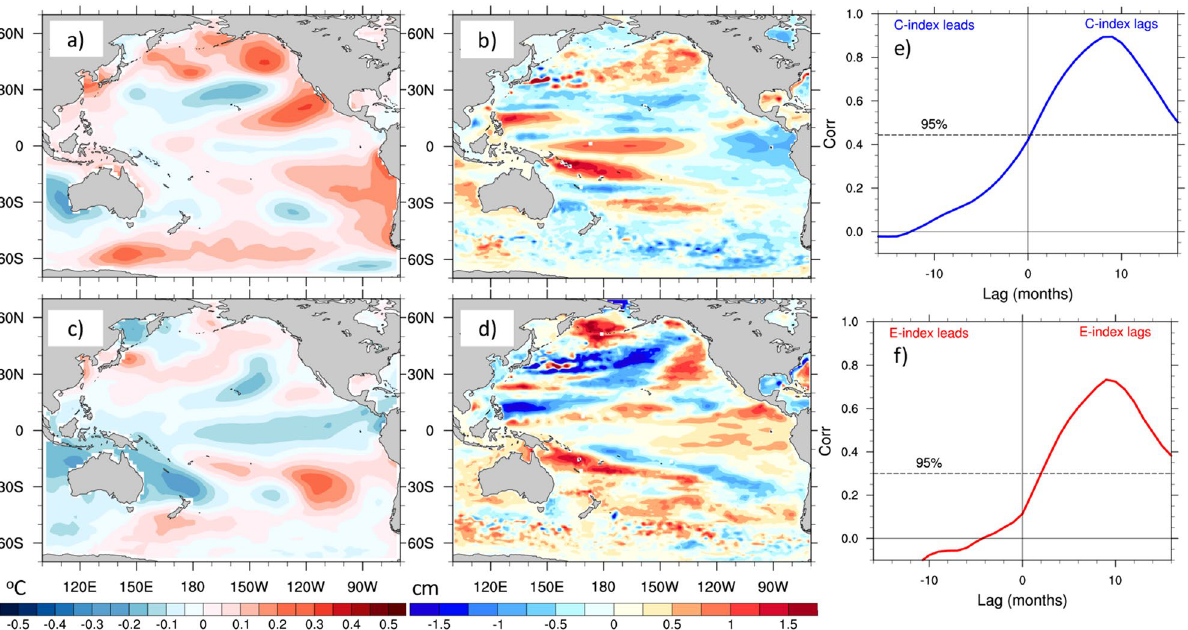
Figure 4. Basin-scale “sensitivity patterns” for CP and EP events. SST ( a , c ) and SSH ( b , d ) structures obtained by solving Eq. (3) for CP (top) and EP (bottom) ENSO events at a lead time t = 9 months. ( e ) Lag-correlation between the index associated with the SST/SSH sensitivity pattern for CP events and the CP index. Positive lags indicate that the sensitivity pattern index leads the CP index. The largest correlation (0.90) is achieved when the sensitivity pattern index leads the CP index by 9 months. ( f ) Same as ( e ), but for the EP index. In this case the largest correlation is 0.73, and is also achieved at a lead time of 9 months. Horizontal dashed lines show the 95% significant level in both